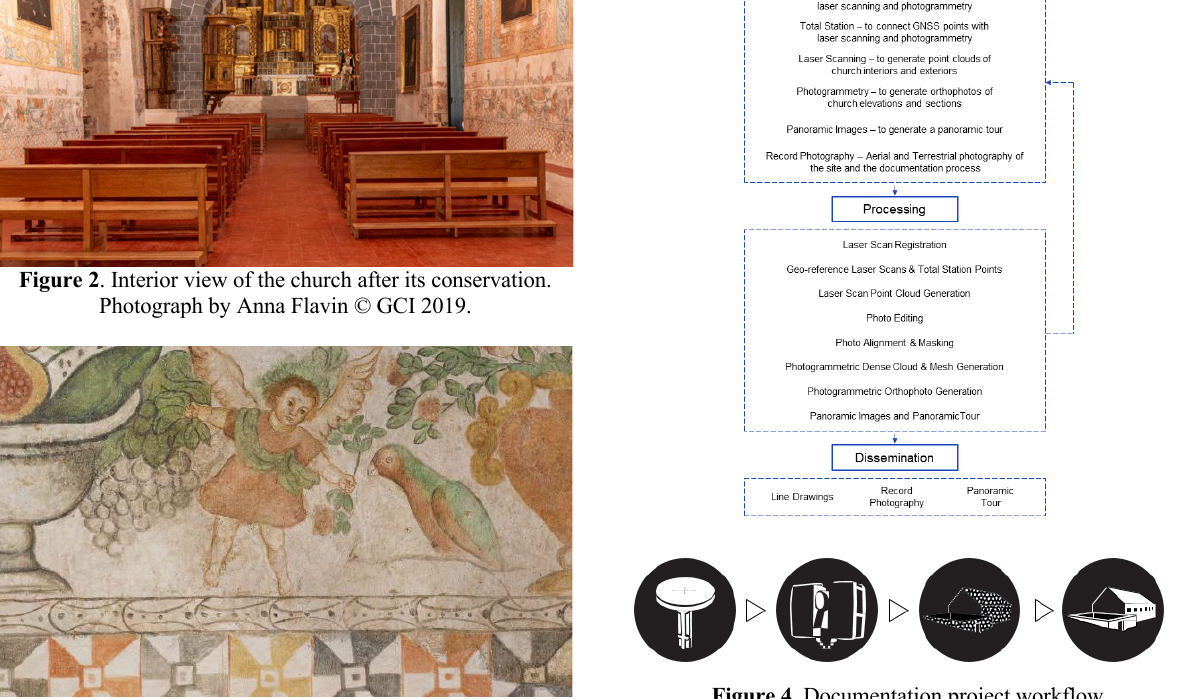
Figure 3 . Mural painting detail of the south wall of the nave. Photograph by CIMS © GCI 2019.